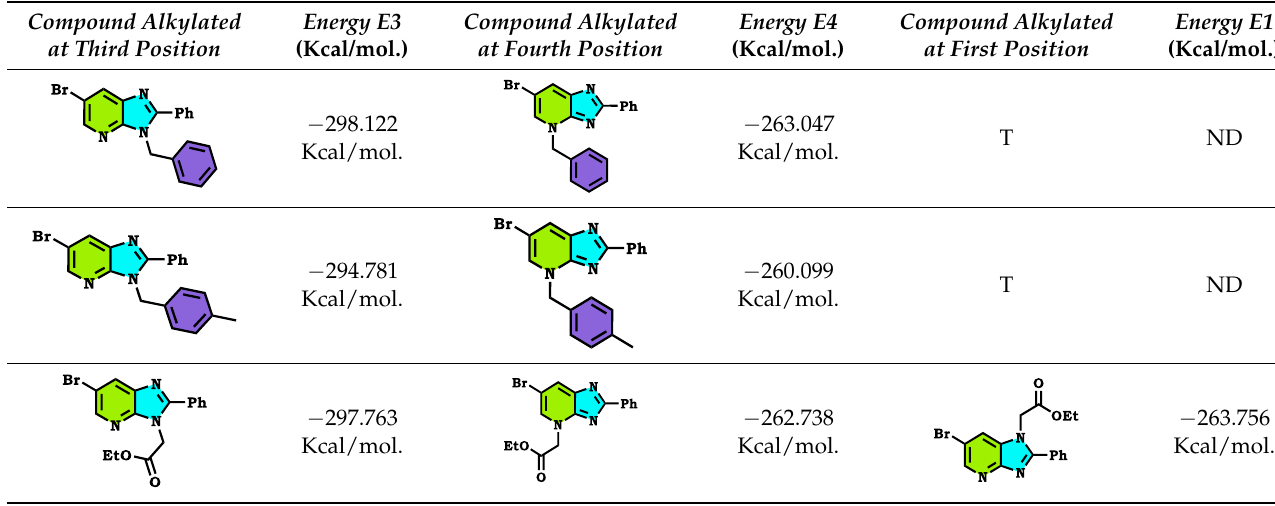
Table 2. Energetic chemical descriptors for 1 – 8 derivatives.